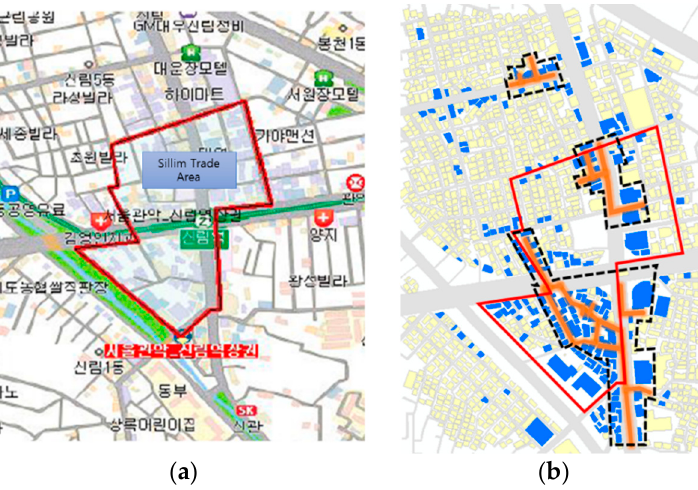
Figure 11. Visual assessment test: ( a ) trade area from the Small Business Development Center (SBDC) market analysis report; ( b ) trade areas from the SBDC (red line) and sum of all the themed street clusters (dashed black line). Blue polygons are buildings that have venues data.